Question: Give a one-sentence summary of this figure.
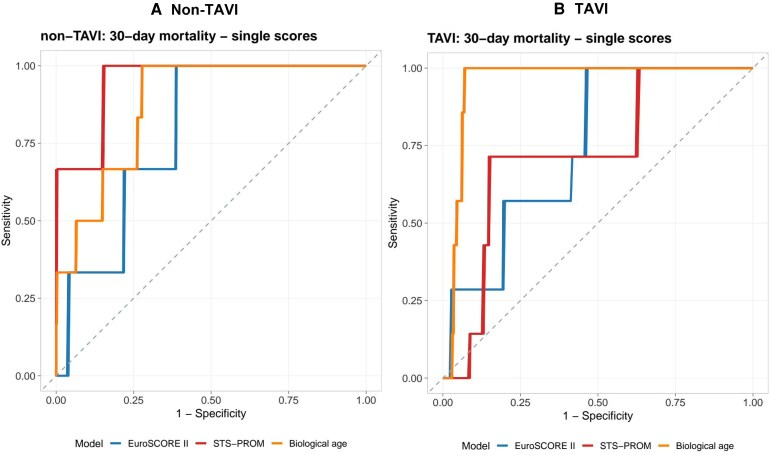
Answer: Receiver operating characteristic curves for 30-day mortality by procedural subgroup. ( A ) Non-TAVI subgroup and ( B ) TAVI subgroup, comparing EuroSCORE II, STS-PROM, and biological age (CXR-Age). Biological age was the strongest single predictor in the TAVI subgroup, whereas STS-PROM was strongest in the non-TAVI subgroup. EuroSCORE II, European System for Cardiac Operative Risk Evaluation II; STS-PROM, Society of Thoracic Surgeons Predicted Risk of Mortality; TAVI, transcatheter aortic valve implantation.